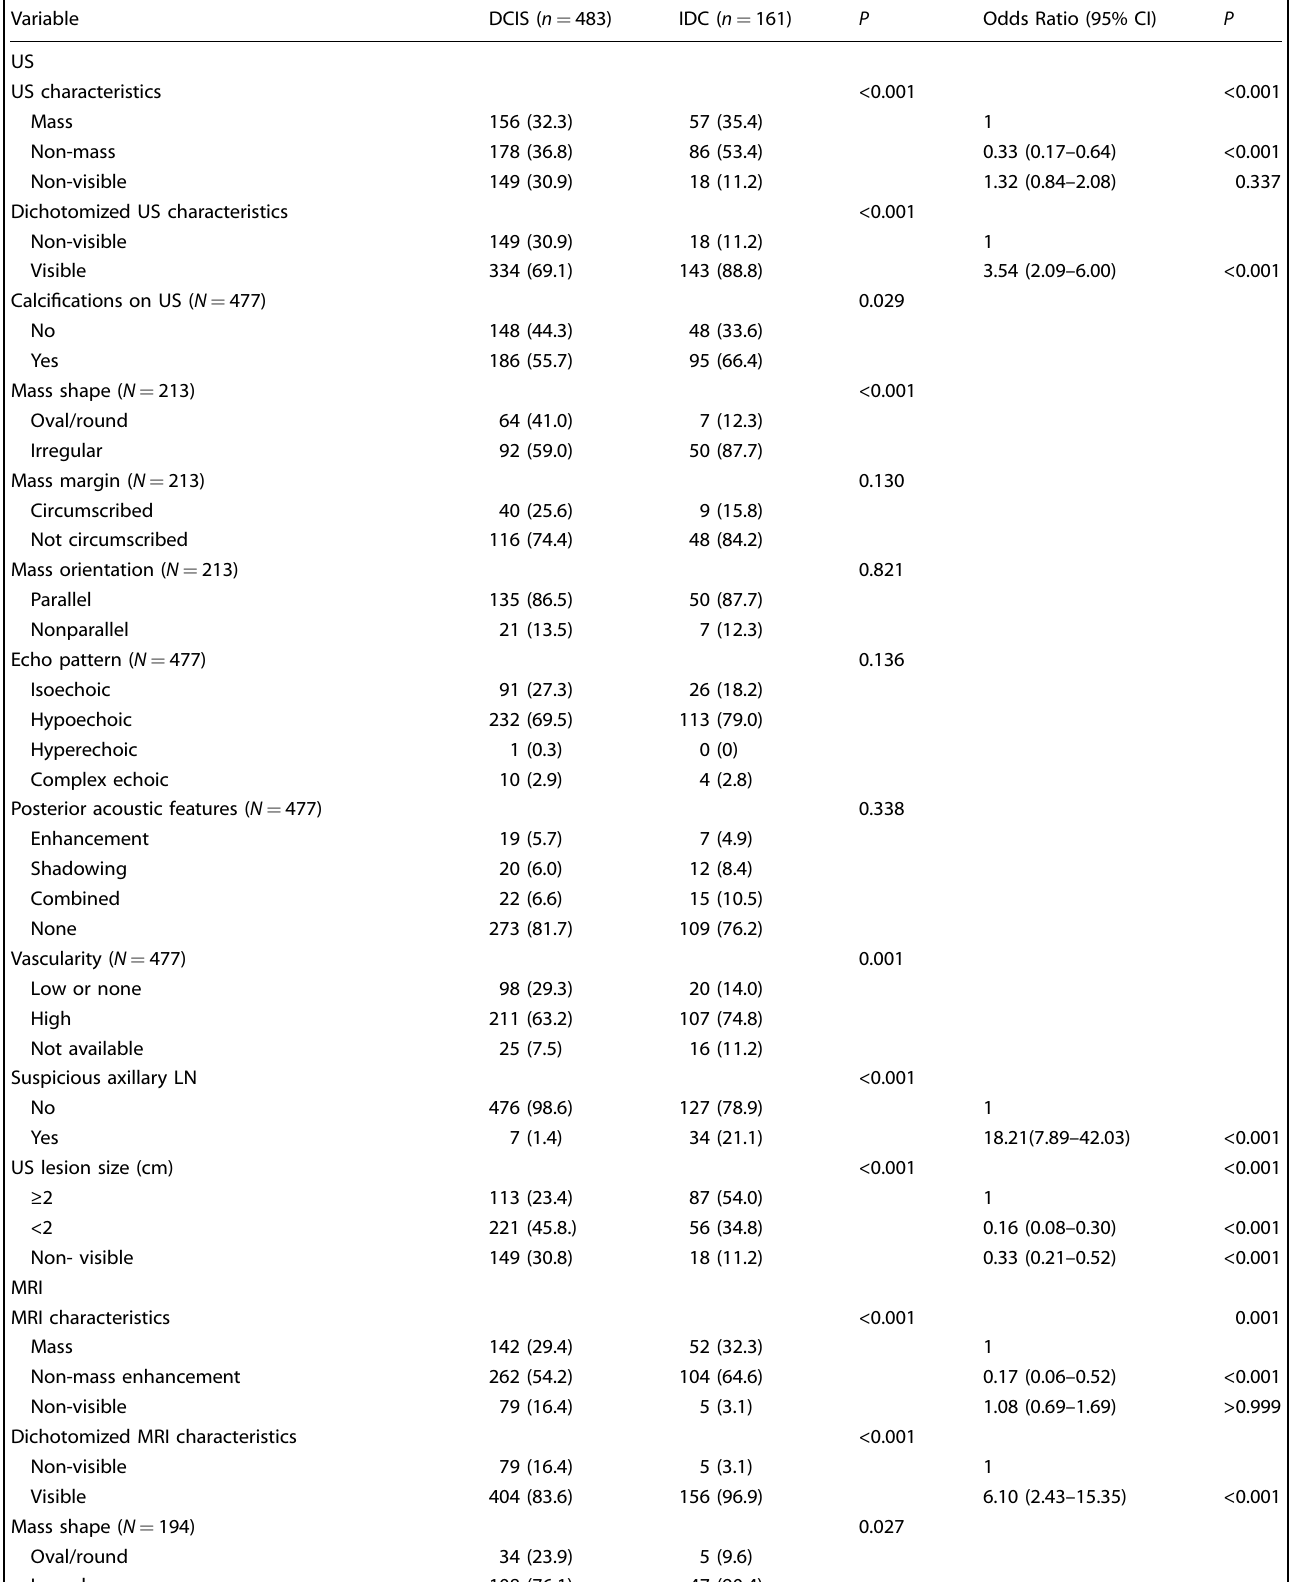
Table 2. Patient characteristics and univariable analysis of factors associated with the histopathologic upgrade to invasive carcinoma (US and MRI fi ndings).